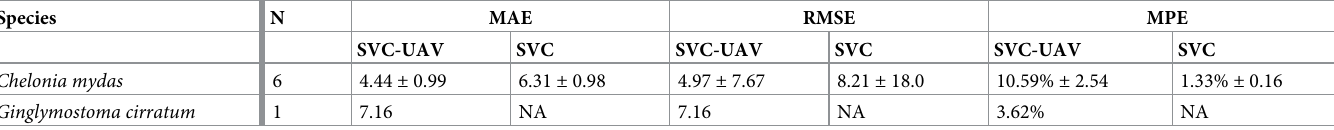
SVC-UAV = stereo-video camera mounted to an unoccupied aerial vehicle, SVC = in-water swimmable stereo-video camera, MAE = mean absolute error, RMSE = root mean square error, and MPE = mean percent error ( ± standard error). In-water SVC measurements were not collected for G. cirratum and standard errors are not provided for G. cirratum as only 1 individual was